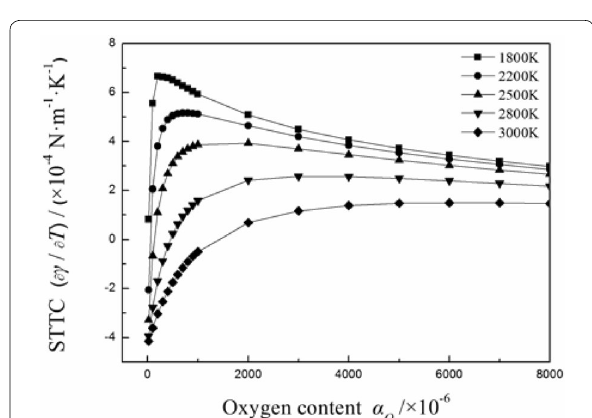
Figure 12 Dependence of surface tension temperature coefficient on oxygen